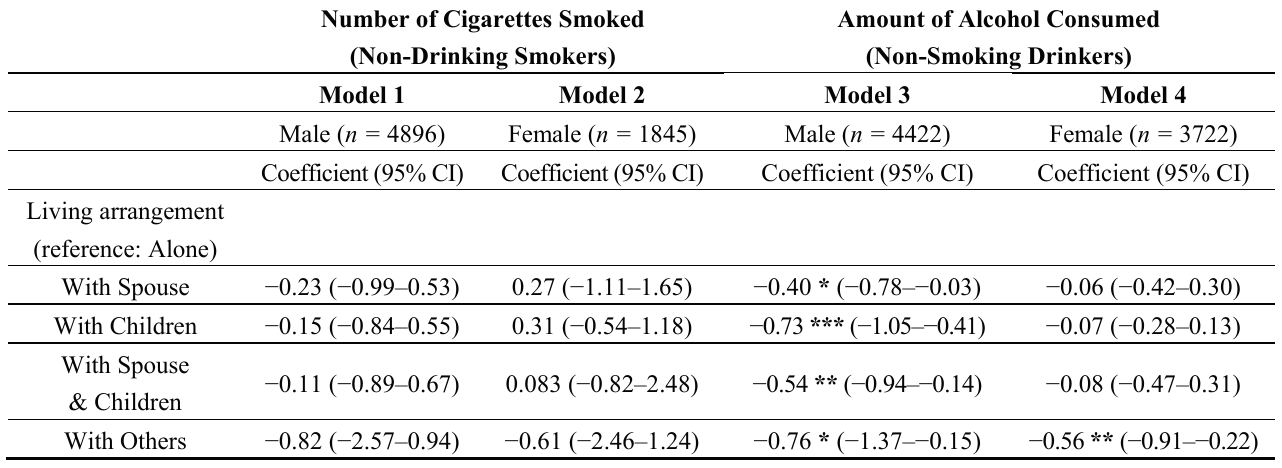
Table 4. OLS regression estimates of number cigarettes smoked and amount of alcohol consumed for non-drinking smokers ( n = 6741) and non-smoking drinkers ( n = 8144), respectively: CLHLS, 1998–2008 b